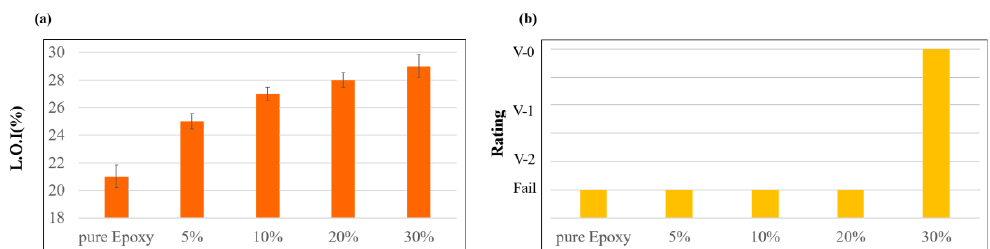
Figure 4. Effect of various Bagasse@ TGIC@DOPO contents on the ( a ) LOI and ( b ) UL-94 of Epoxy/Bagasse@TGIC@ DOPO IPN composites.